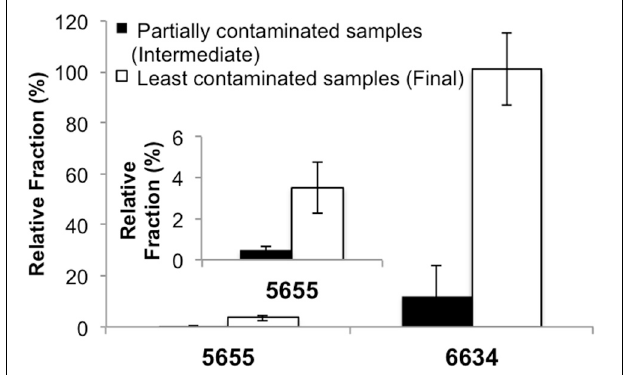
FIGURE 2 | qPCR quantification of relative fractions of Vulcanibacillus sp. and Orenia sp. enriched from the formation water bacterial communities. The partially contaminated samples (Sample 5655-6S and 6634-S42) were collected during “swabbing” before geochemical conditions became stable and contained more contamination, while the least contaminated samples (Sample 5655-S14 and 6634-S46) were the final swabs after the in-situ geochemical parameters leveled off. The subfigure indicates the results of 5655 illustrated with narrower scale.